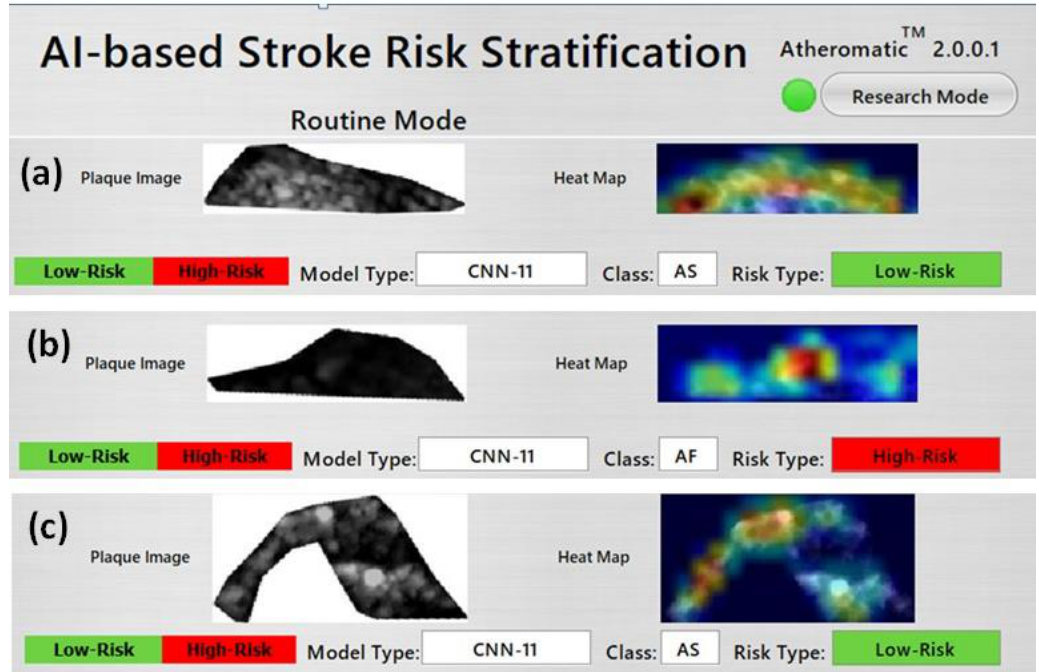
Figure 19. GUI screenshot of the Atheromatic™ 2.0 TL system with three example cases ( a – c